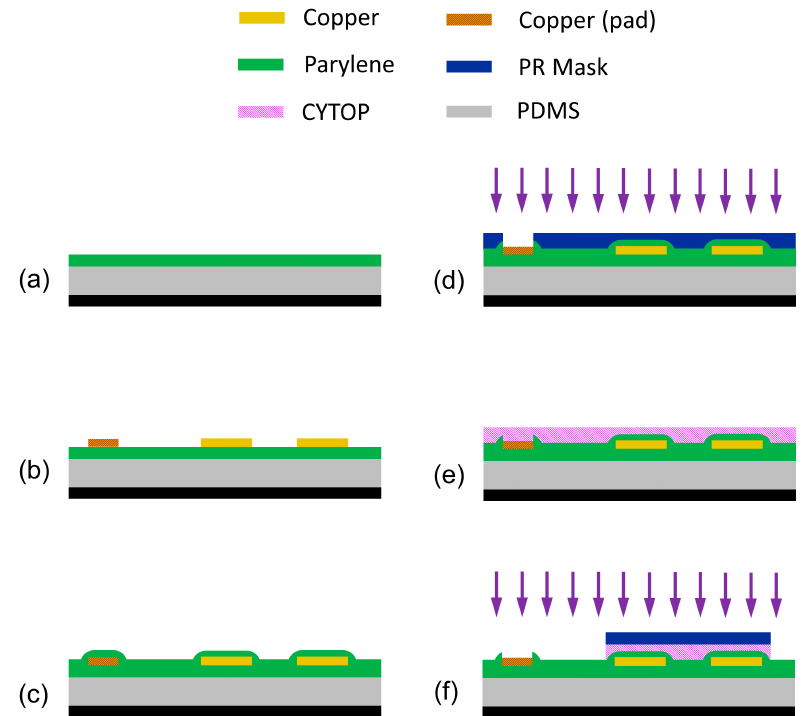
Figure 2. Micromachining fabrication process of flexible electrowetting array. ( a ) 250 µm of PDMS was spin coated onto a carrier wafer. After PDMS was cured a 10 µm layer of Parylene C was deposited as an adhesive layer; ( b ) 275 nm of copper was deposited via magnetron sputtering and then patterned and wet etched into areal density modulated array electrodes along with traces and pads; ( c ) Another 2.5 µm of Parylene C was deposited over the whole wafer to act as a pinhole free dielectric layer; ( d ) The Parylene C insulator was etched in the region directly over pads for electrical contacts. A thick photoresist was patterned to act as a mask while Parylene C was etched used 400 W oxygen plasma; ( e ) 1 µm of CYTOP was spin coated and cured to create a highly hydrophobic surface. The curing was done at a low temperature to minimize thermal strain to the flexible substrate; ( f ) CYTOP layer was pattered using a photoresist mask to protect the disk directly over the electrowetting electrodes. CYTOP was etched using 200 W oxygen plasma.